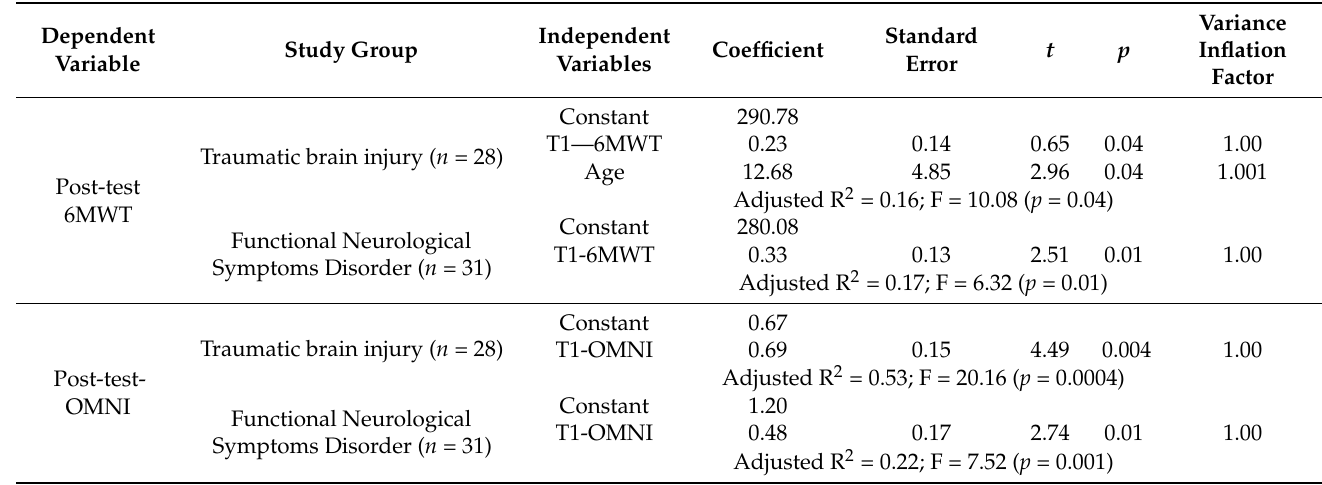
Table 3. Variables predicting walking ability and exercising rate of perceived exertion (OMNI)